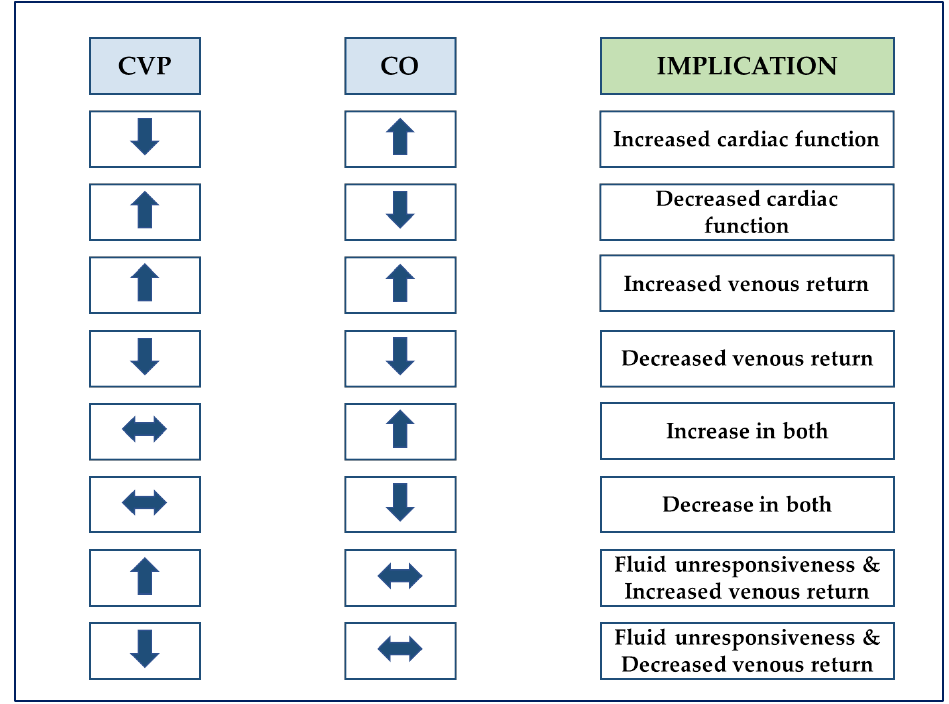
Figure 1. Interpretation of coupled changes in cardiac output and central venous pressure. CO, car- diac output; CVP, central venous pressure. Adapted with permission [37].